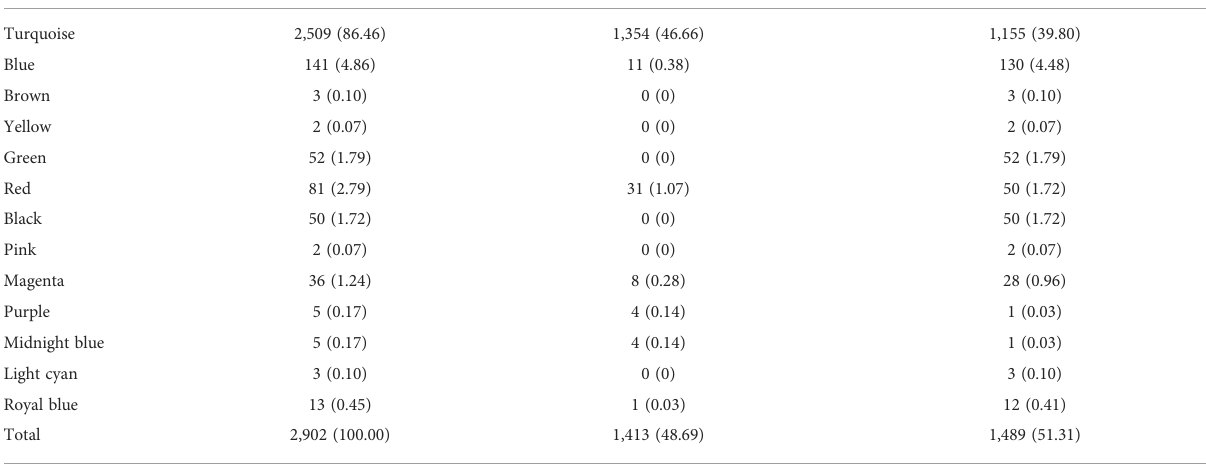
TABLE 3 Number of all differentially expressed (DE) genes in different co-expressed modules. Co-expression